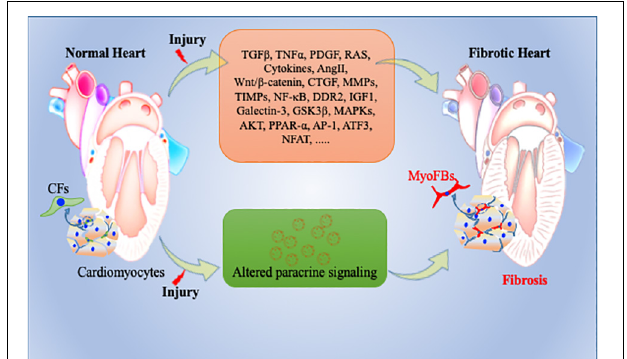
FIGURE 3 | Pathophysiology of cardiac fibrosis. During normal remodeling, adequate ECM proteins secreted by cardiac fibroblasts (CFs) are important to maintain cellular integrity in heart. However, upon cardiac injury, CFs transdifferentiate into activated myofibroblasts, secrete excessive amounts of ECM proteins, and expand the cardiac interstitium as a wound healing process. Many key molecular determents are involved in this repair process including exosomes. Altered molecular and paracrine signaling pathways can contribute to exacerbated activation and trans- differentiation of fibroblasts to myofibroblasts and to adverse/pathological cardiac remodeling and heart failure. CFs = Cardiac fibroblasts; myoFBs: myofibroblasts.